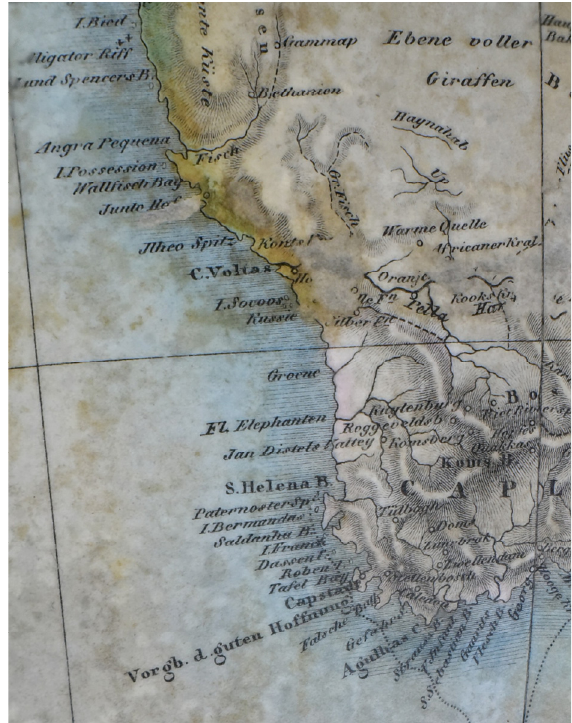
Figure 11. The description of the occurrence of giraffes. Source: Map Collection of the Faculty of Science, Charles University.